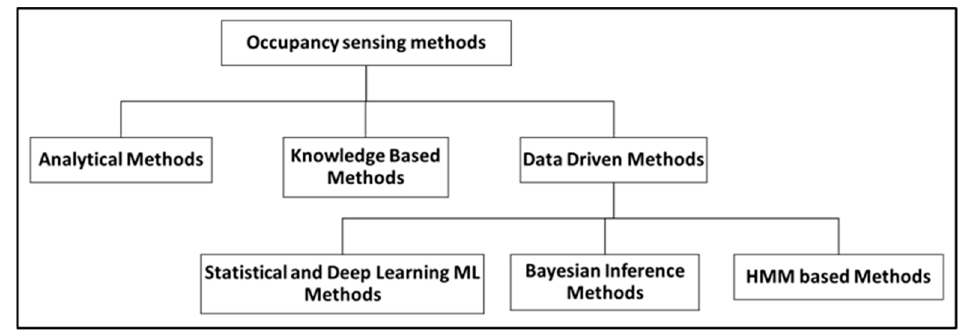
Figure 3. Taxonomy of occupancy sensing methods. Table 5. ADPs conformance for each application